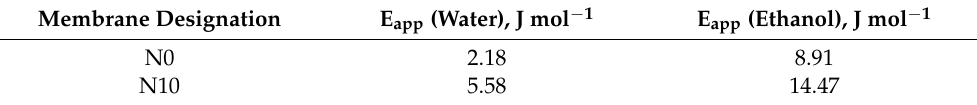
Table 4. The apparent activation energy of N0 and TFN N10 membranes. Membrane